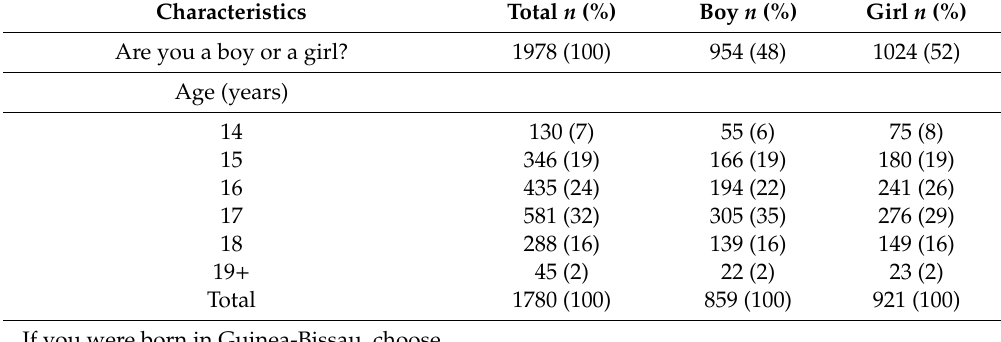
Table 1. Table with selected socioeconomic variables of participants’, by gender *. Adolescents attending schools in Bissau, June